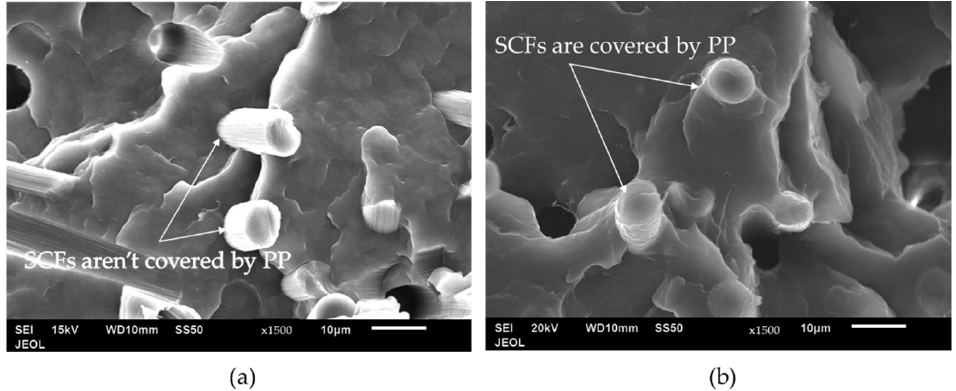
Figure 6. SEM images of 20 wt. % of SCF-reinforced Polypropylene (PP/20SCF) of ( a ) PP3 and ( b ) PP23.